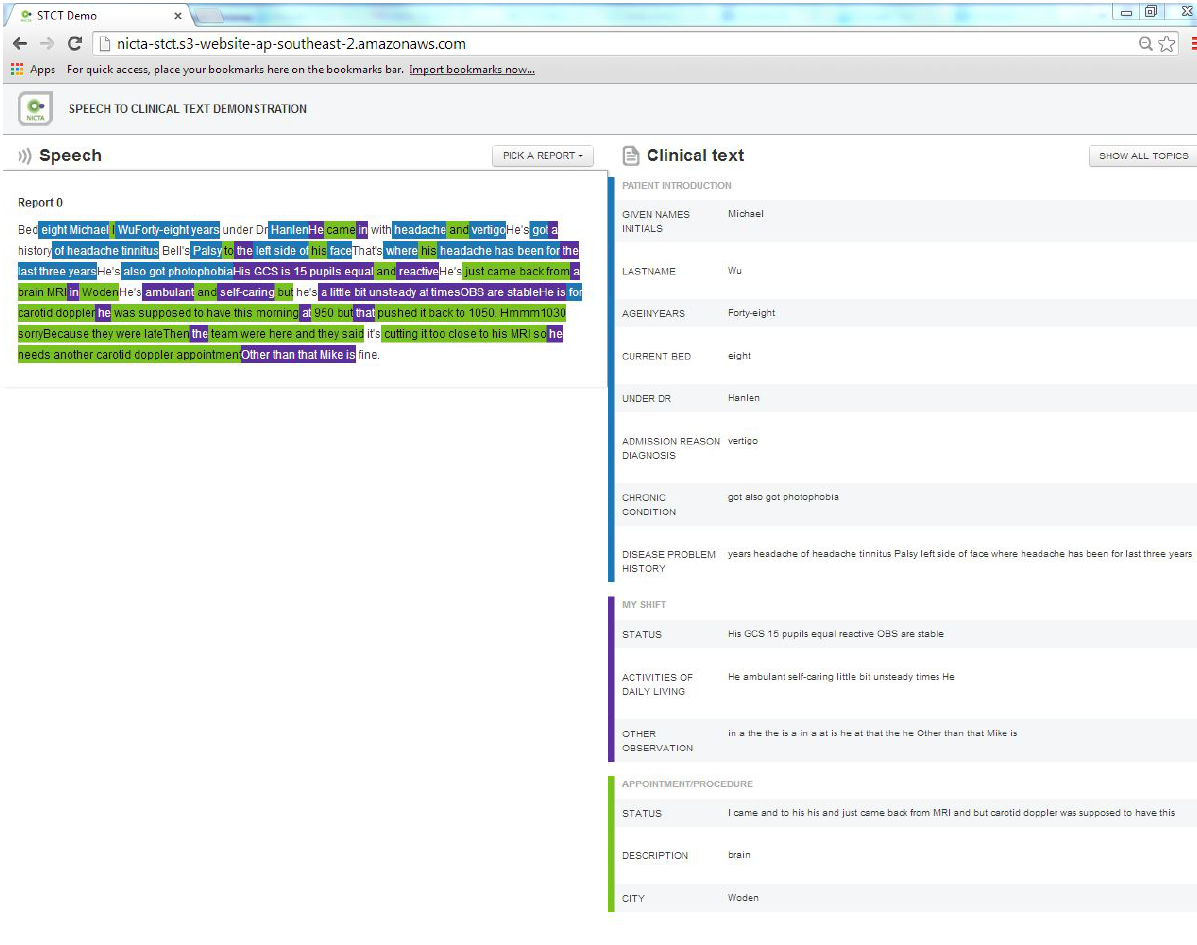
Figure 7. National Information and Communications Technology, Australia (NICTA) speech to clinical text demonstration system that visualizes the example